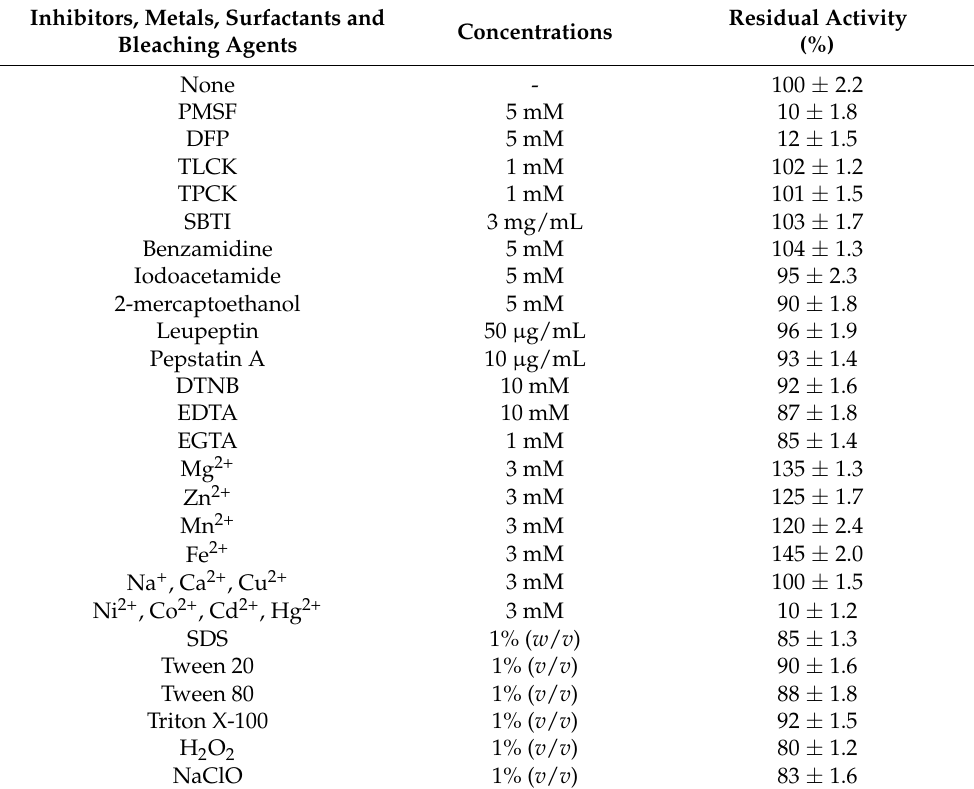
Table 3. Effects of various inhibitors, metal ions, surfactants, and bleaching agents on purified protease